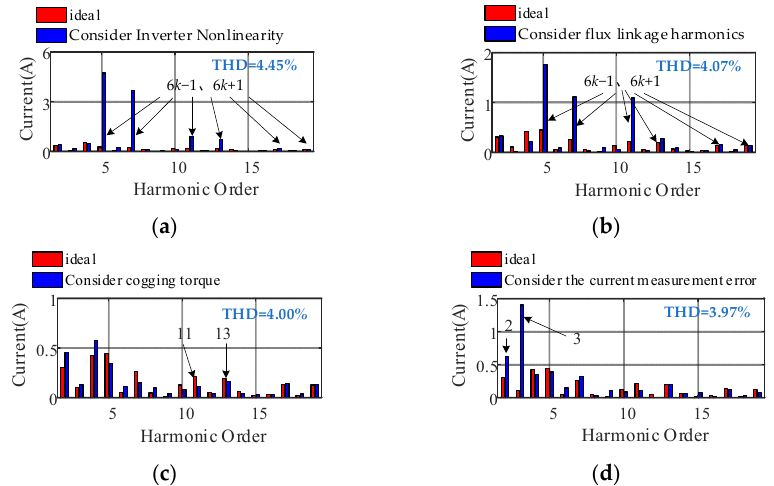
Figure 29. Comparison results of current harmonic spectrum diagrams: ( a ) comparison results of current harmonic considering the inverter nonlinearity; ( b ) comparison results of current harmonic considering the nonsinusoidal distribution of the air ‐ gap magnetic field; ( c ) comparison results of current harmonic considering the cogging torque; ( d ) comparison results of current harmonic considering the current measurement error.